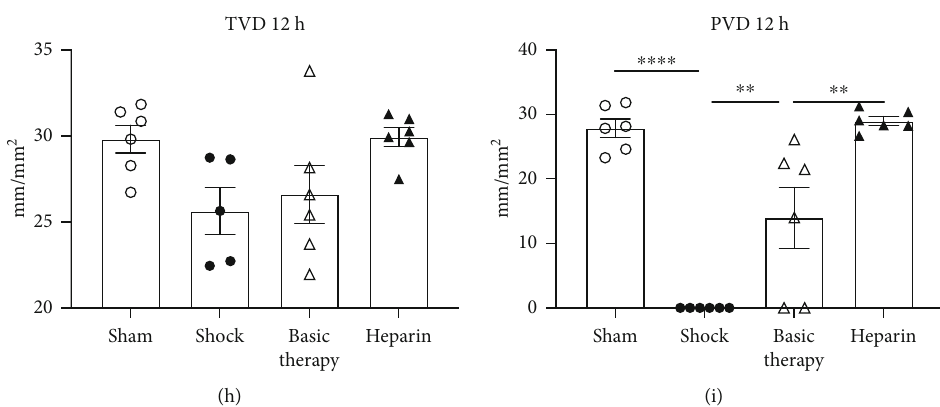
Figure 3: Representative images and parameters of microcirculation in the jejunal villi at T3 and T12. (a) Representative images of jejunal villus mucosa at T3 and T12. (b – e) Microcirculation parameters PPV, MFI, TVD, and PVD of jejunal villi at T3. (f – i) The PPV, MFI, TVD, and PVD of jejunal villi at T12. ∗∗ P < 0 : 01 ; ∗∗∗ P < 0 : 001 ; ∗∗∗∗ P < 0 : 0001 .